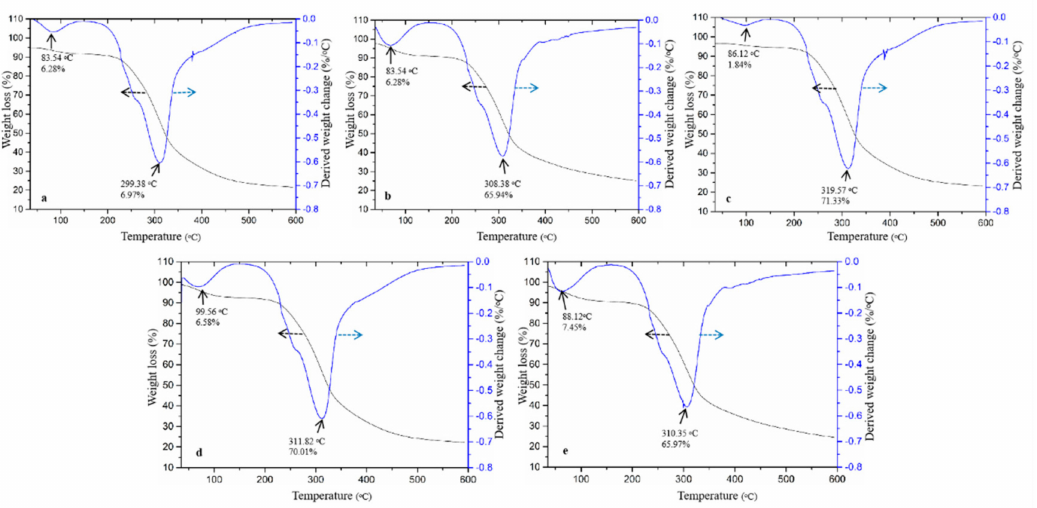
Figure 2. Thermograms of ODF-SPI mixture ( a ) and ODF-SPI conjugates after dry heating at 60 o C for 6 h ( b ), 12 h ( c ), 24 h ( d ) and 48 h ( e